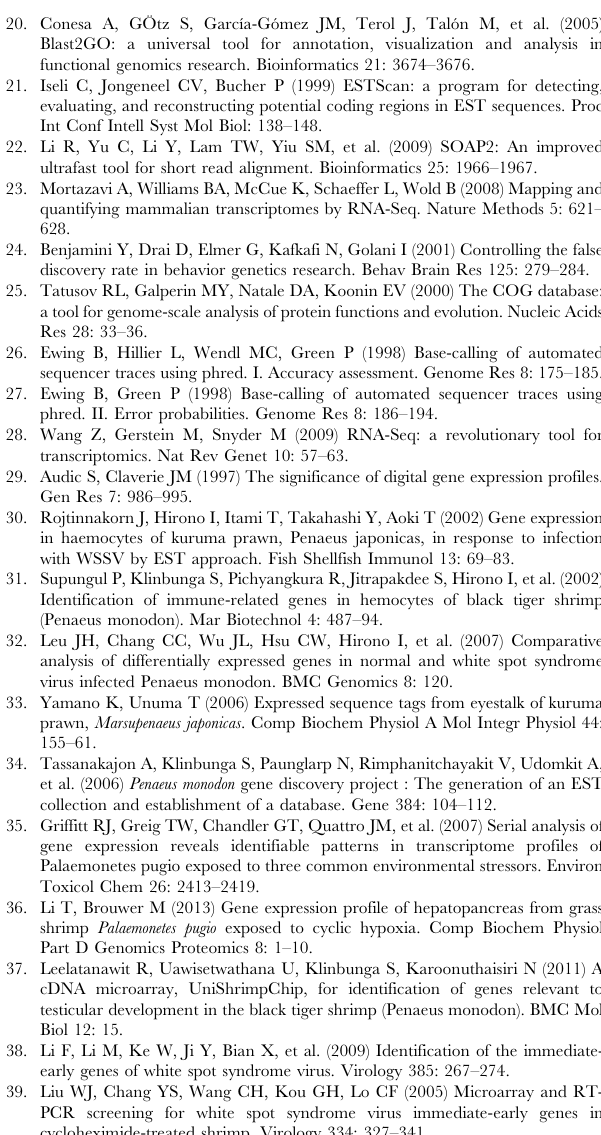
Table S4 Immune-related genes screened from the late infection